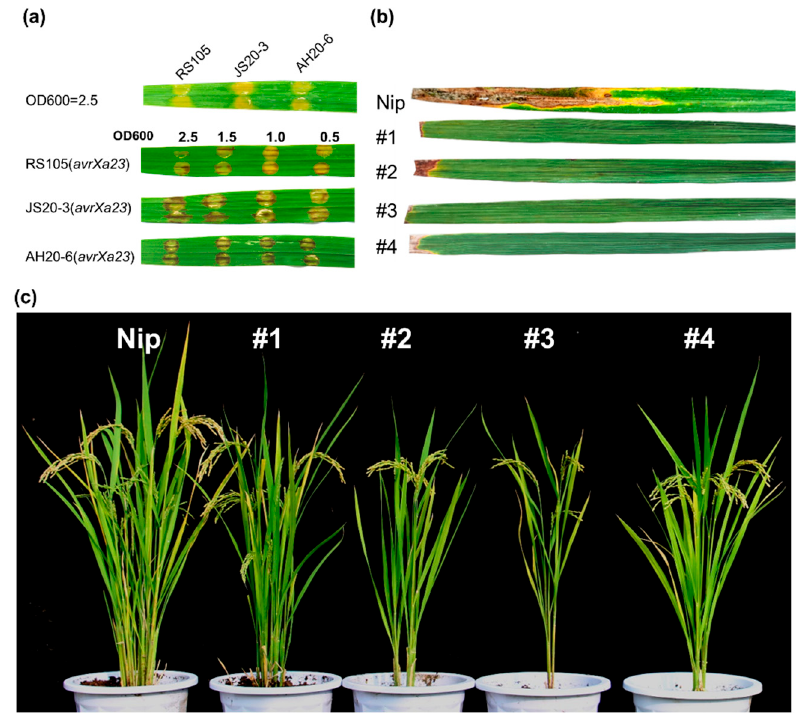
Figure 2. Generation of Xa23p1.0 transgenic rice. ( a ) The phenotype of CBB23 was photographed 5 days after infiltration with transformed Xoc strains containing empty vector and pHZWavrXa23 at different OD600 values. ( b ) Disease phenotypes of Xa23p1.0 transgenic T 2 plants and wild-type Nipponbare (Nip) at tillering stage inoculated with Xoo strain PXO99 A by leaf-clipping method. ( c ) Phenotypes of the T 2 plants at mature stage in Beijing field trial.